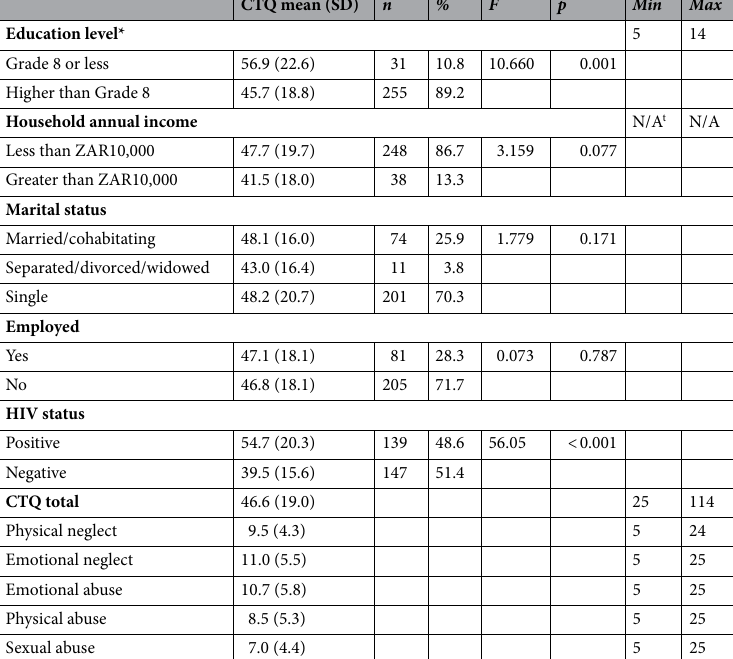
Table 2. Childhood Trauma Questionnaire (CTQ) sum scores, subscale scores, and comparison of CTQ sum scores by selected sociodemographic indicators, N = 286. *Education level was measured as years of school completed; a nnual income was measured as a binary variable therefore min and max values are not